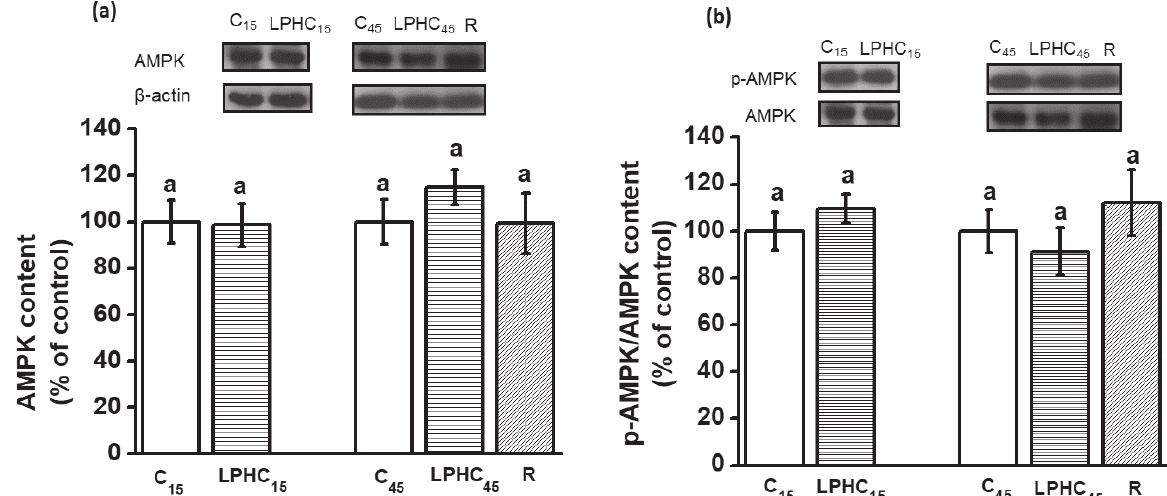
Figure 4. AMPK (a) and p-AMPK/AMPK (b) content in the hypothalamus of the C C , LPHC , and R groups. Data are expressed as mean ± standard error of the mean (M ± SEM) of 6-8 rats per group. 45 45 One-way ANOVA test for 45 days of treatment and Student’s t -test for 15 days of